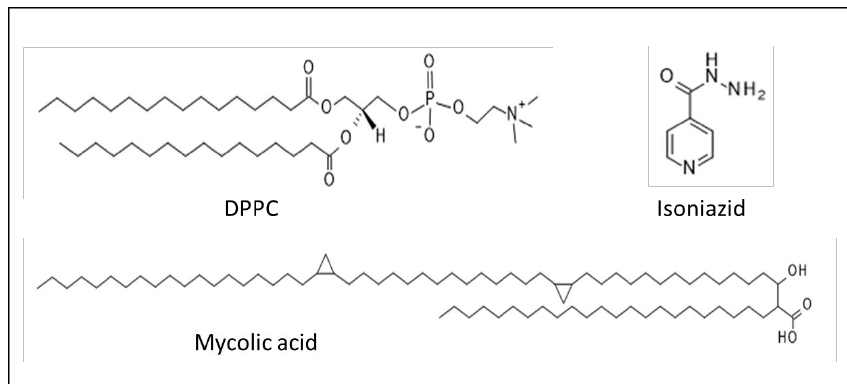
Figure 8. Chemical composition of the drug and lipids applied in Langmuir monolayer experiments